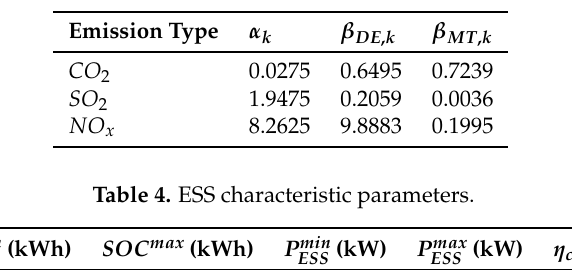
Figure 5. Start-up cost of the dispatchable units in terms of the time the unit has been off. Table 3. Parameters of the externality costs and the emission factors of the main grid generation.